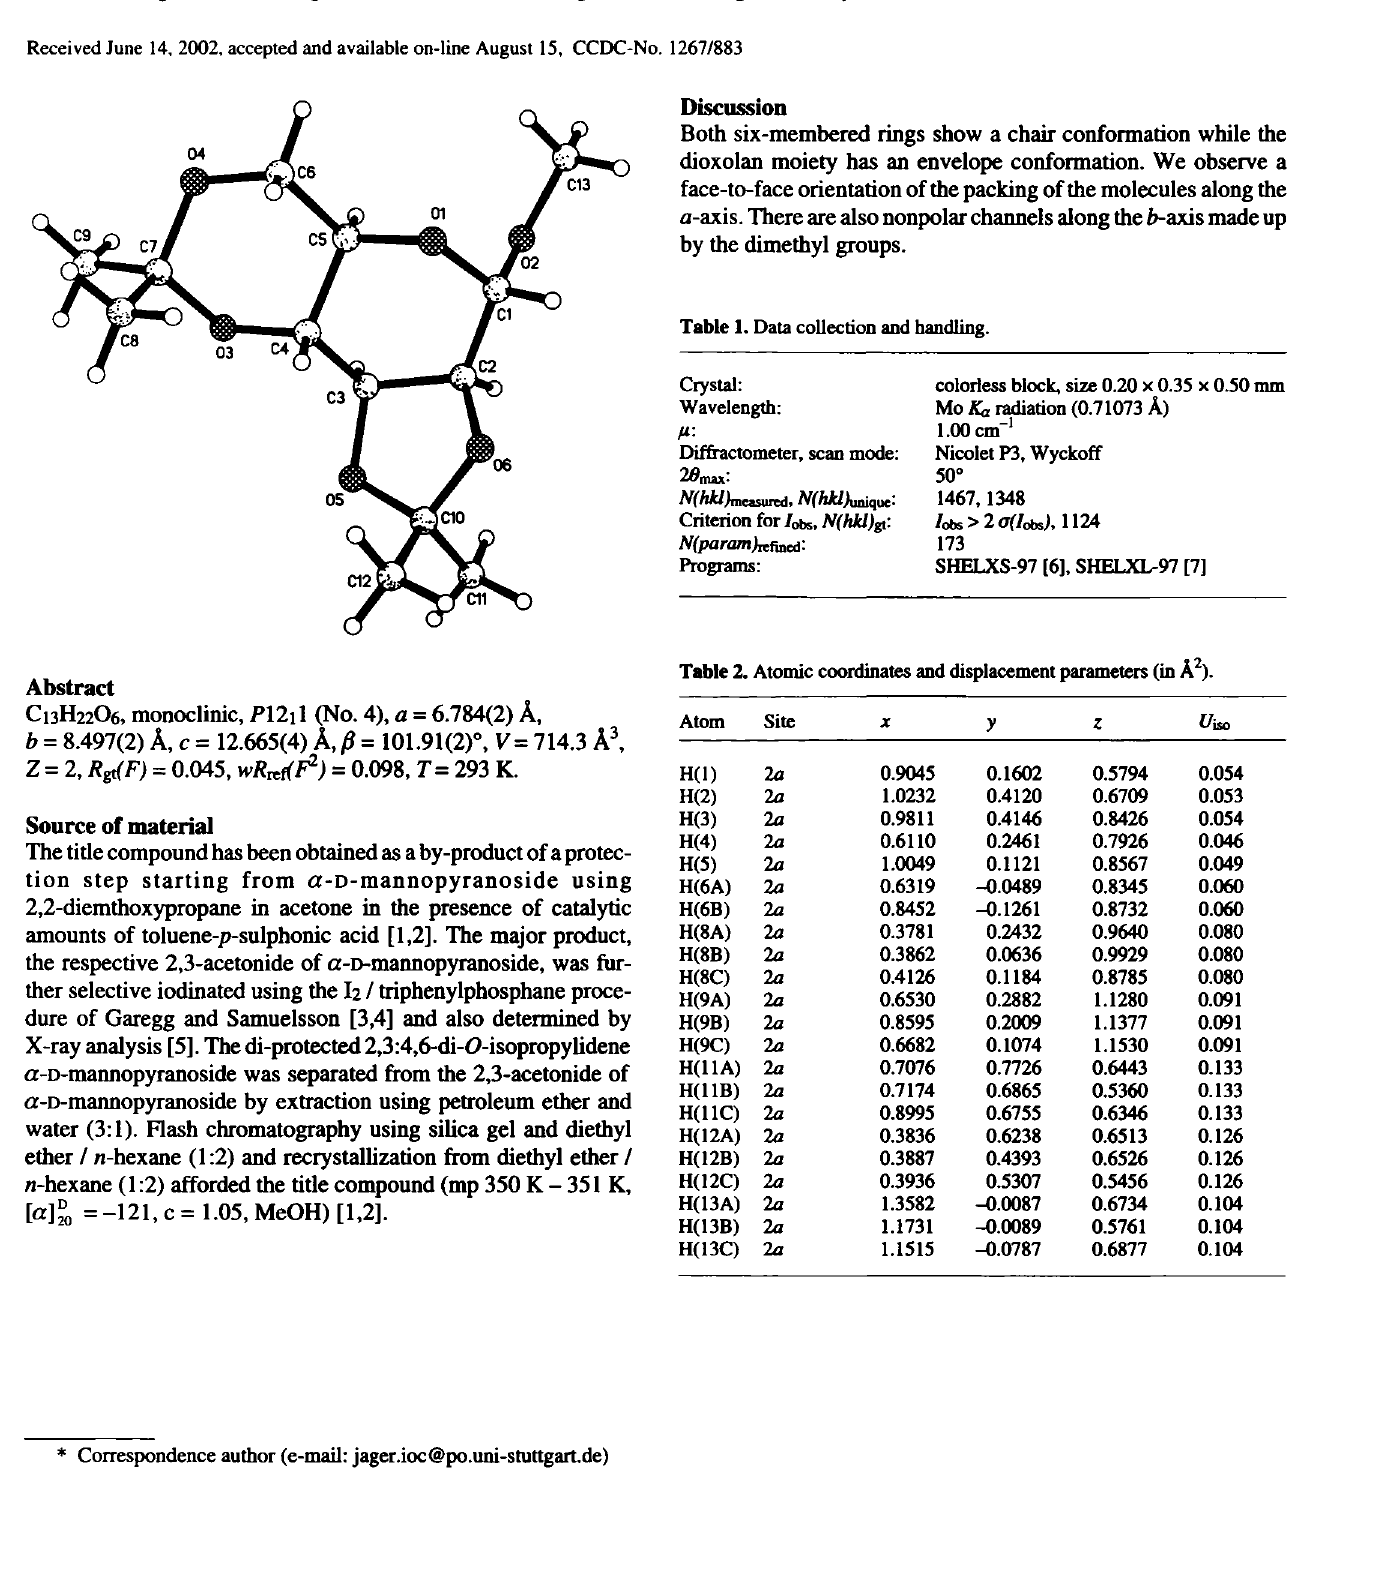
Table 1. Data collection and handling.